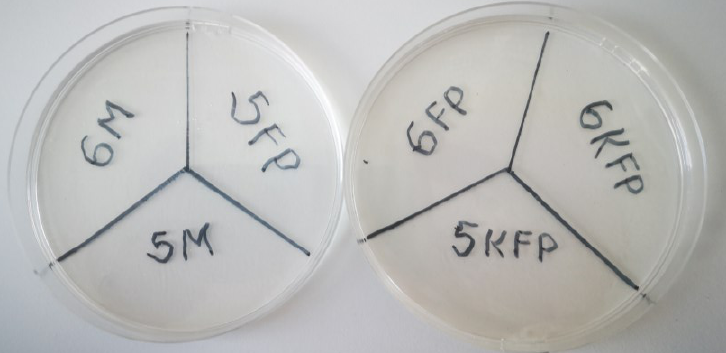
Figure 16. No bacteria growing was detected on film-forming gels. M — film-forming gels, stored for